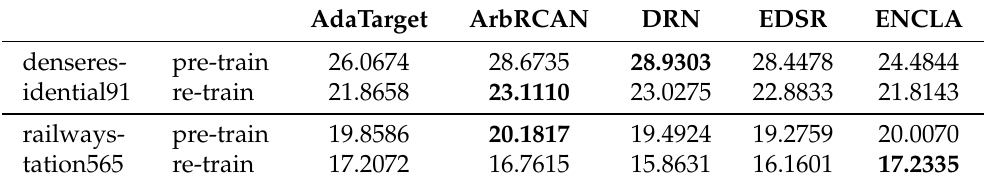
Table 8. PSNR Evaluation for generalization with DIV2K pre-training or FY4ASRcolor re-training. AdaTarget ArbRCAN DRN EDSR